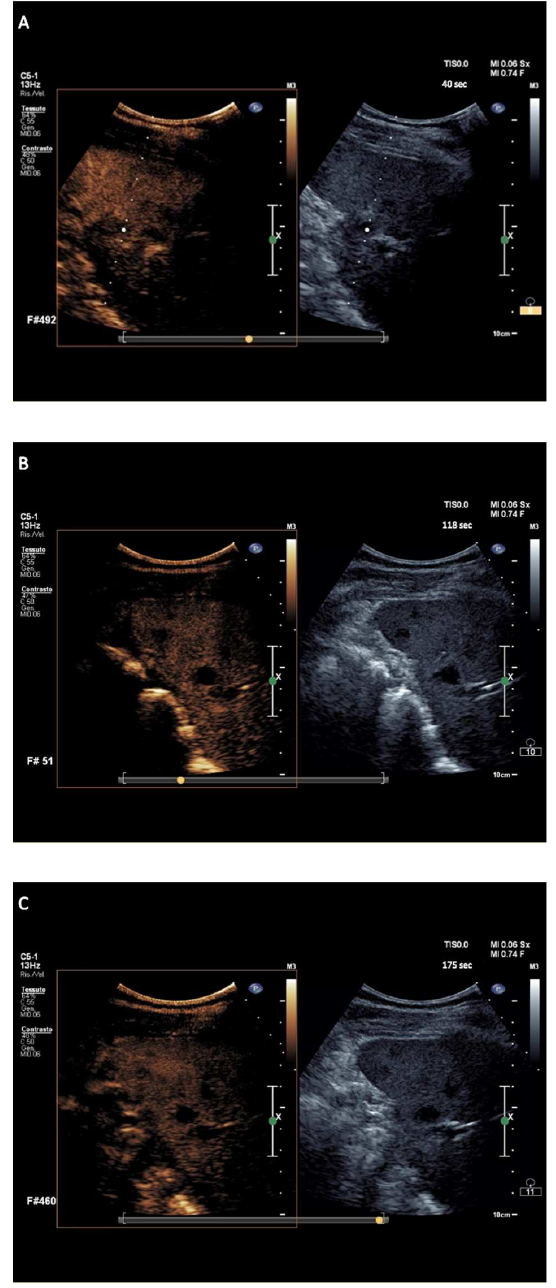
Figure 4. Major features of CEUS according to the exploratory diagnostic criteria. ( A – C ) showing indolent non-Hodgkin lymphoma nodules with sufficiently marked wash-out, at 118 s from contrast agent injection.